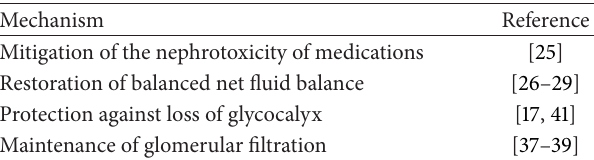
Table 2: Pharmacodynamic properties of human albumin with nephroprotective